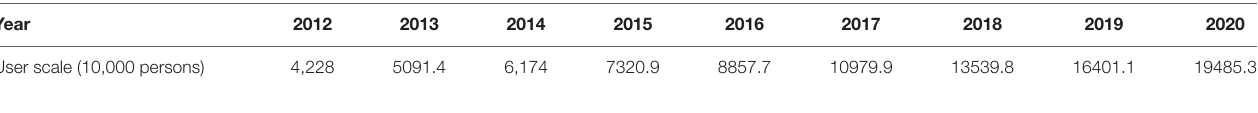
TABLE 1 | Size of online education in China from 2012 to